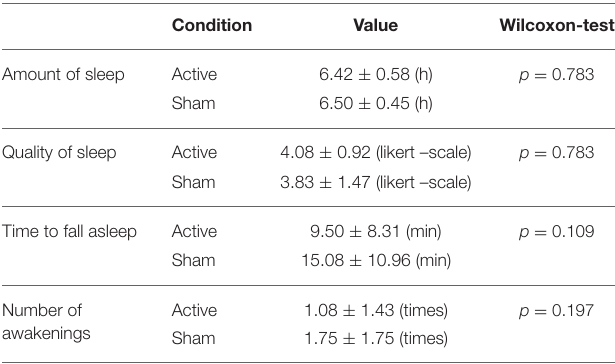
TABLE 1 | The self-reported measures of sleep quality in the active and sham condition ( n = 6